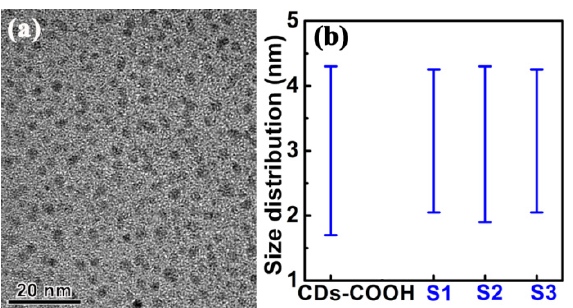
Figure 3. A typical TEM image of CDs and the size distributions of CDs-COOH, S1, S2, and S3.